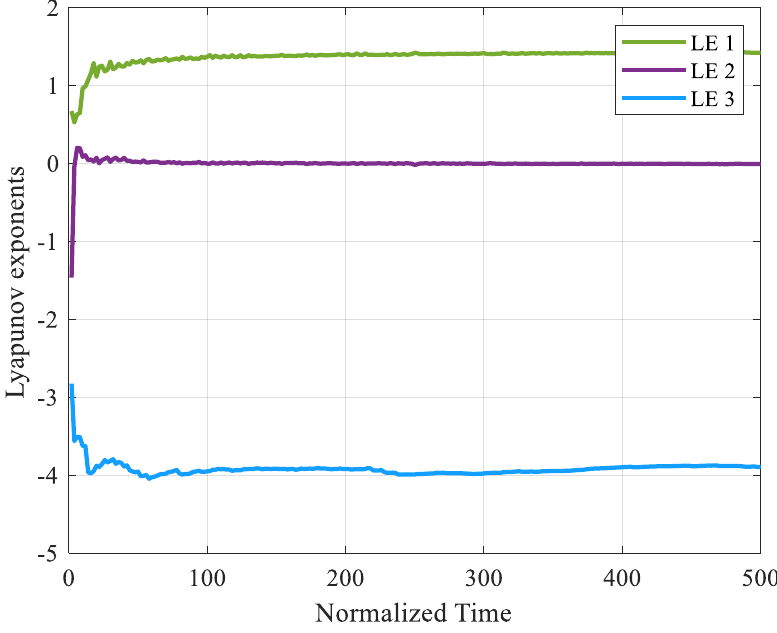
Figure 3. Lyapunov exponents of proposed fractional-order system.